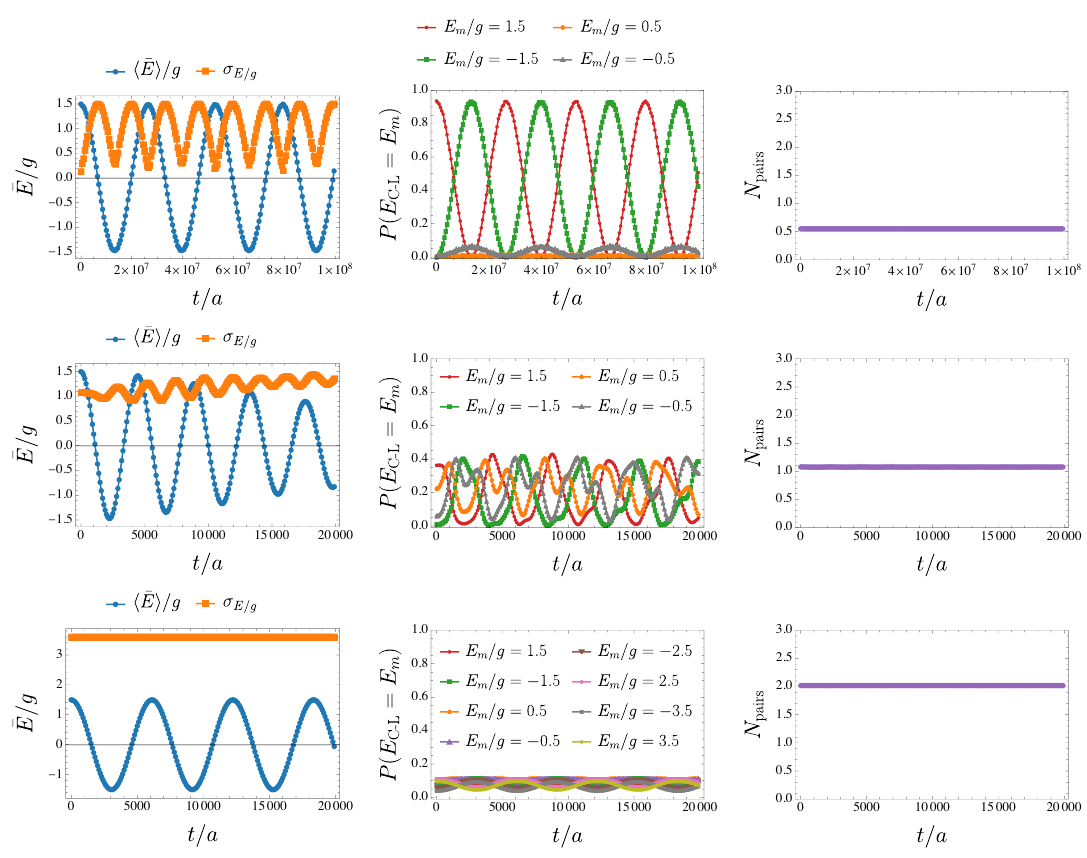
(cid:10) ¯ (cid:11) Figure 4. The expectation values of the spatially averaged electric field E /g , the standard deviation of the spatially averaged electric field σ , the probability to measure field E on the m E/g central link P ( E = E ) , and the number of electron-positron pairs N as functions of time C-L m pairs in the k = 3 quench for m = 50 , with three different spatial circle sizes mL = 8 (top panel), g mL = 4 (middle panel) and mL = 1 (bottom panel) on an N = 10 lattice. For the same reason as in figure 2, we set l = 10 for mL = 8 , 4 simulations and l = 30 for mL = 1 simulation. max max action is not large and the field is not localized to a specific initial value (in units of g